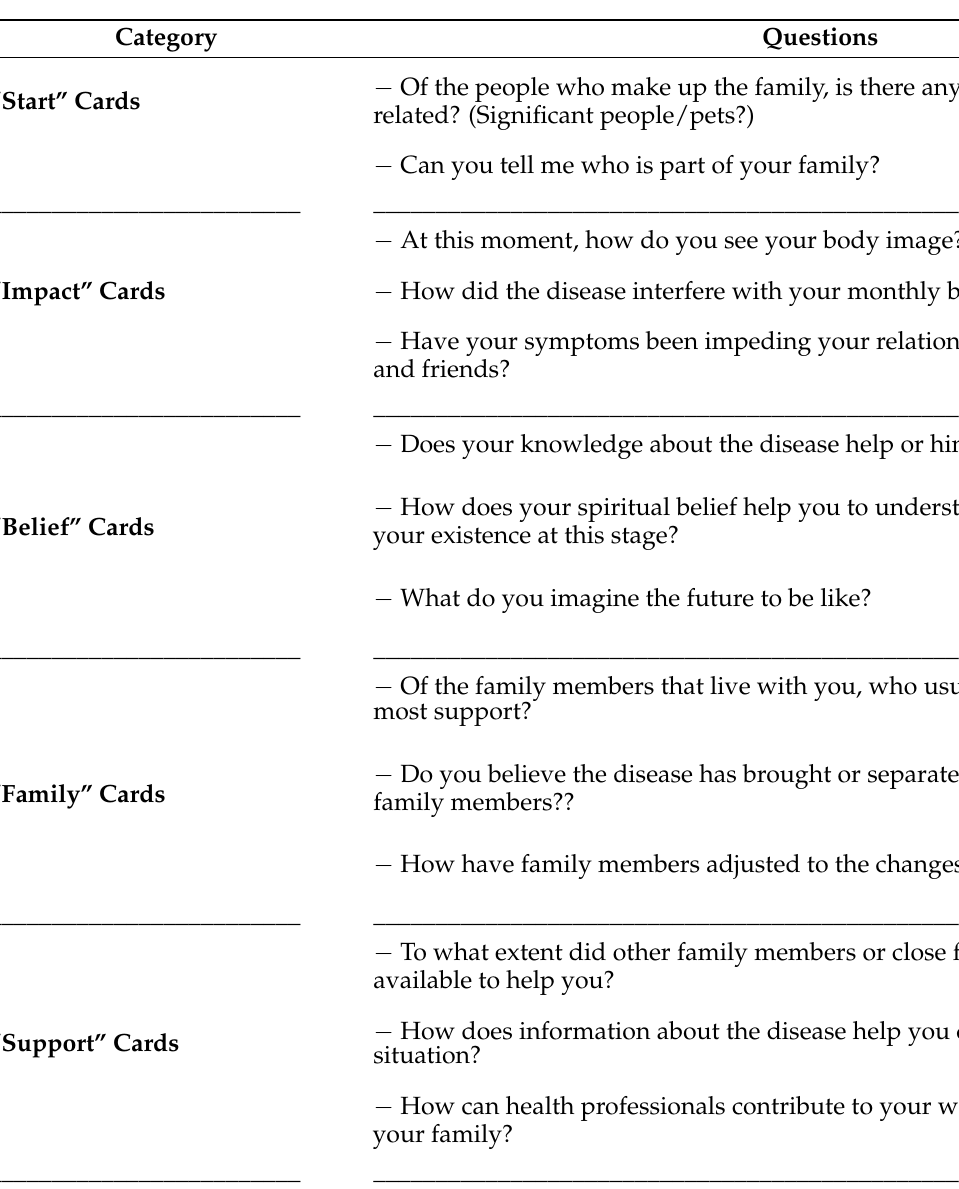
Table 1. Examples of Category and Questions that make up the “ Pallium Game